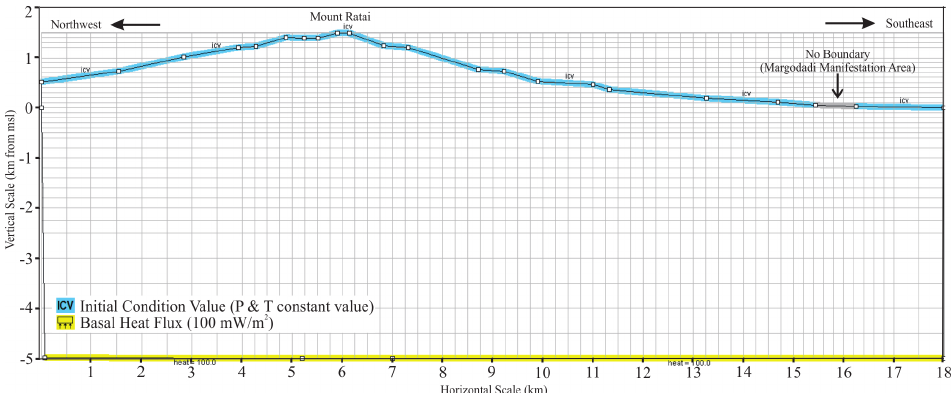
Fig. 2. The grid domain and boundary conditions of the Way Ratai from a numerical simulation model.